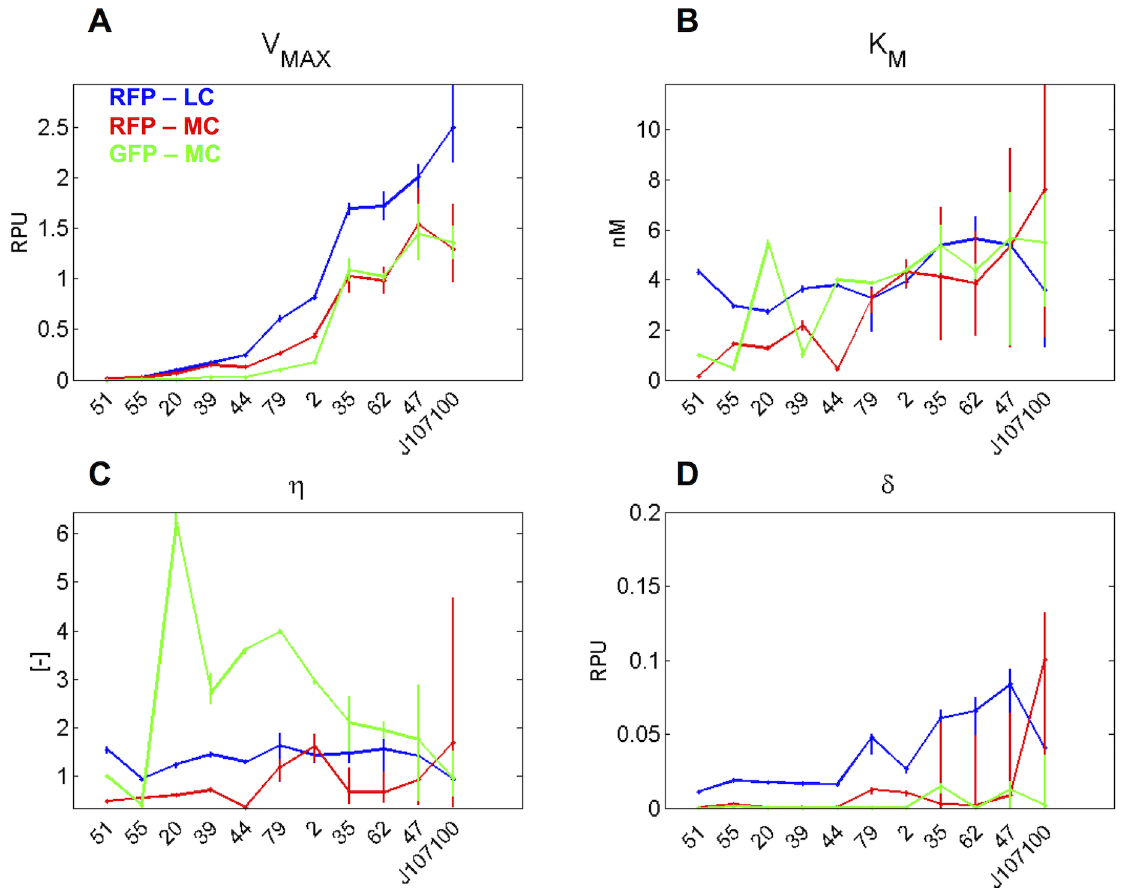
Fig 5. Hill function parameter values obtained by fitting the repression curves of the promoters in the regulated mode. Three different measurement systems are reported, as indicated on the